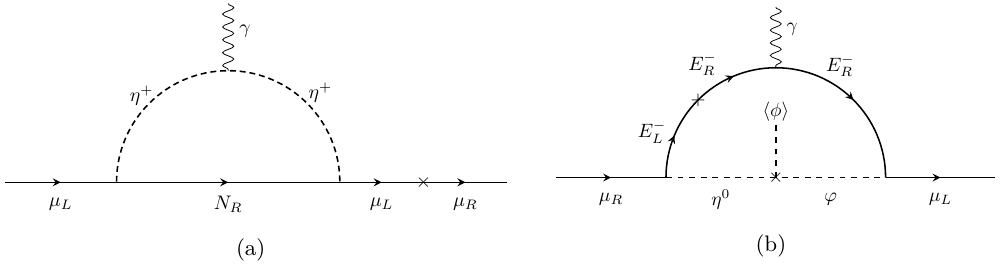
Figure 5 . 1-loop contributions to the muon anomalous magnetic moment. The diagram (a) leads to a negative value of ∆ a µ < 0 . With the inclusion of a vector-like lepton E in diagram (b), a positive value of ∆ a µ > 0 is